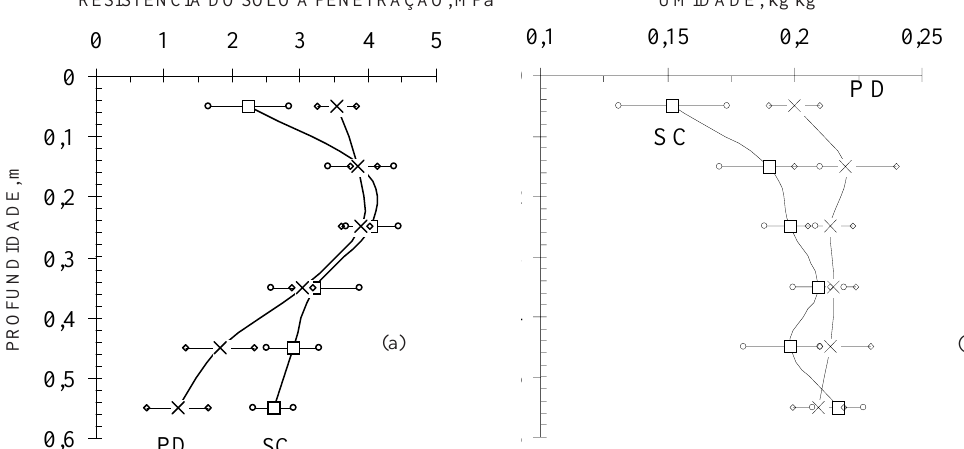
Figura 1. Valores médios e intervalo de confiança (95%) de resistência do solo à penetração (a) e umidade (b) dos solos cultivados com milho no sistema convencional (SC) e no plantio direto (PD) em um Latossolo